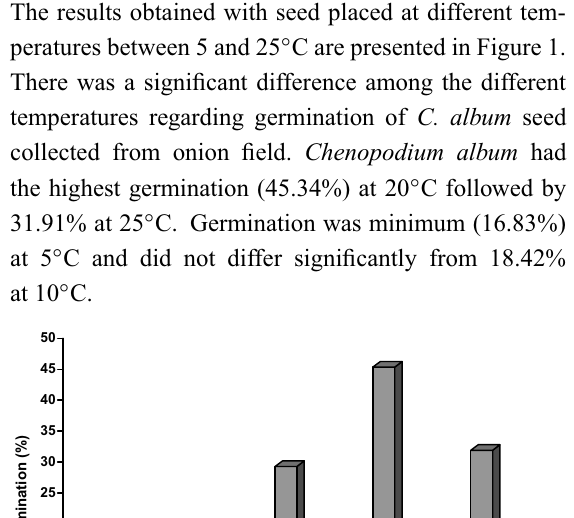
Fig. 2 – Effect of temperature on germination of progeny of C. album seed collected from Leek